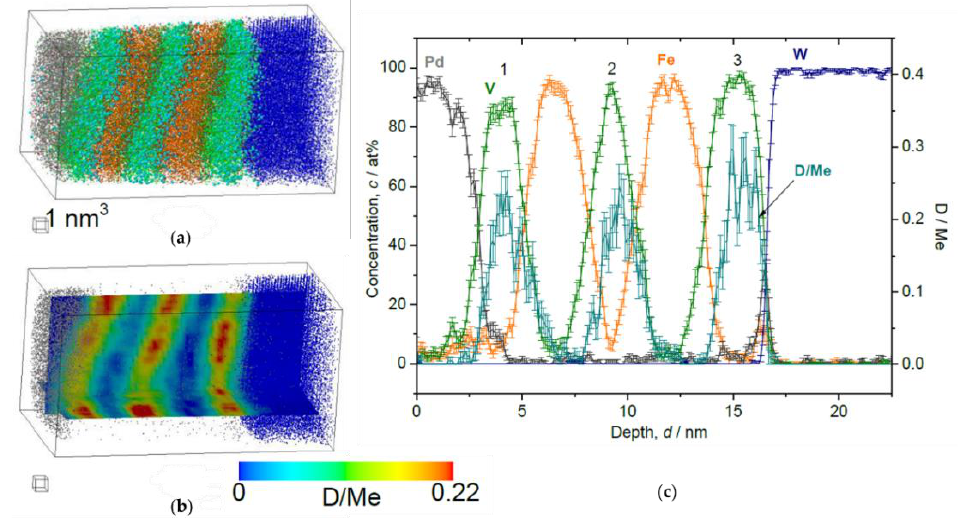
Figure 11. Reconstructed volume of Fe/V multi-layer (12 nm × 12 nm × 23 nm), loaded with D 2 10 Pa, analyzed at 30 K. ( a ) The whole volume of reconstruction (grey: Pd, green: V, orange: Fe, blue: W, light blue: D). ( b ) Iso-concentration map of D concentration ( c D = 0.22 D/Me) from the same reconstruction in ( a ). ( c ) Depth concentration profile from 5 nm ϕ cylinder volume. The c D in the 3rd V is higher than in the other 2 V layers.